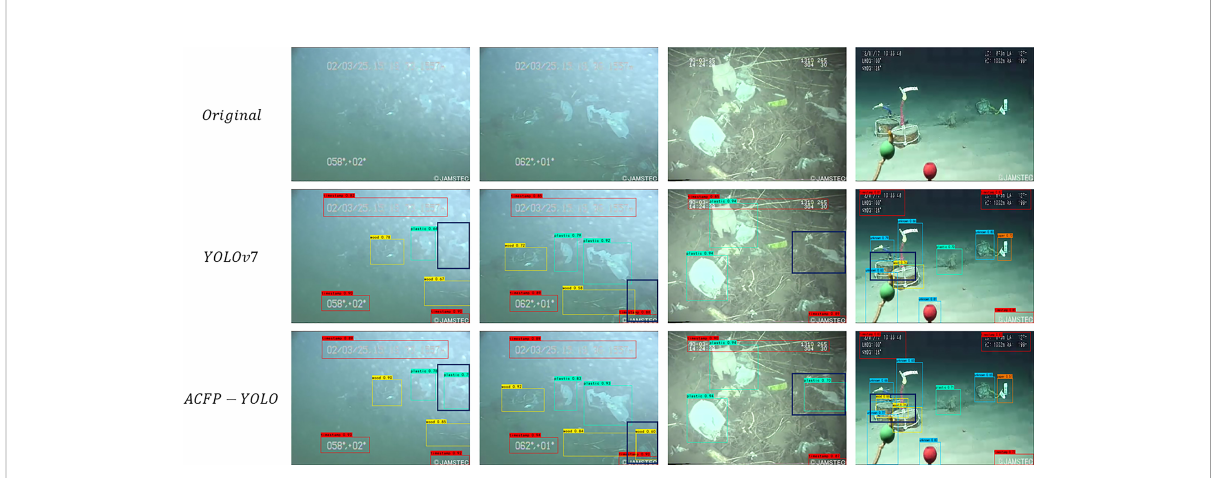
FIGURE 9 The fi rst line Original is the original image of the dataset, the second line is the detection effect map of YOLOv7, and the third line is the detection effect map of